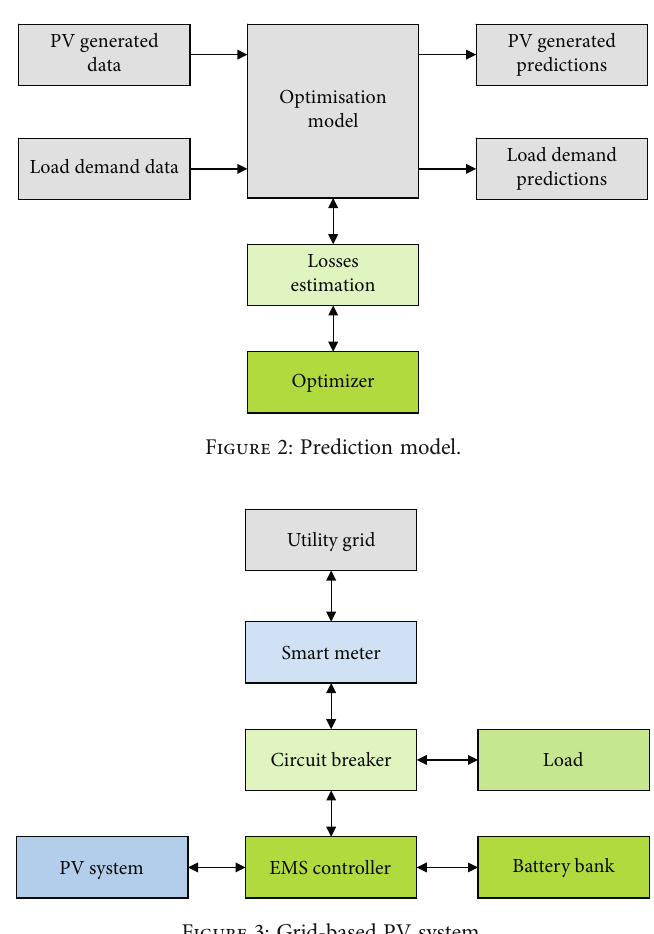
Figure 3: Grid-based PV